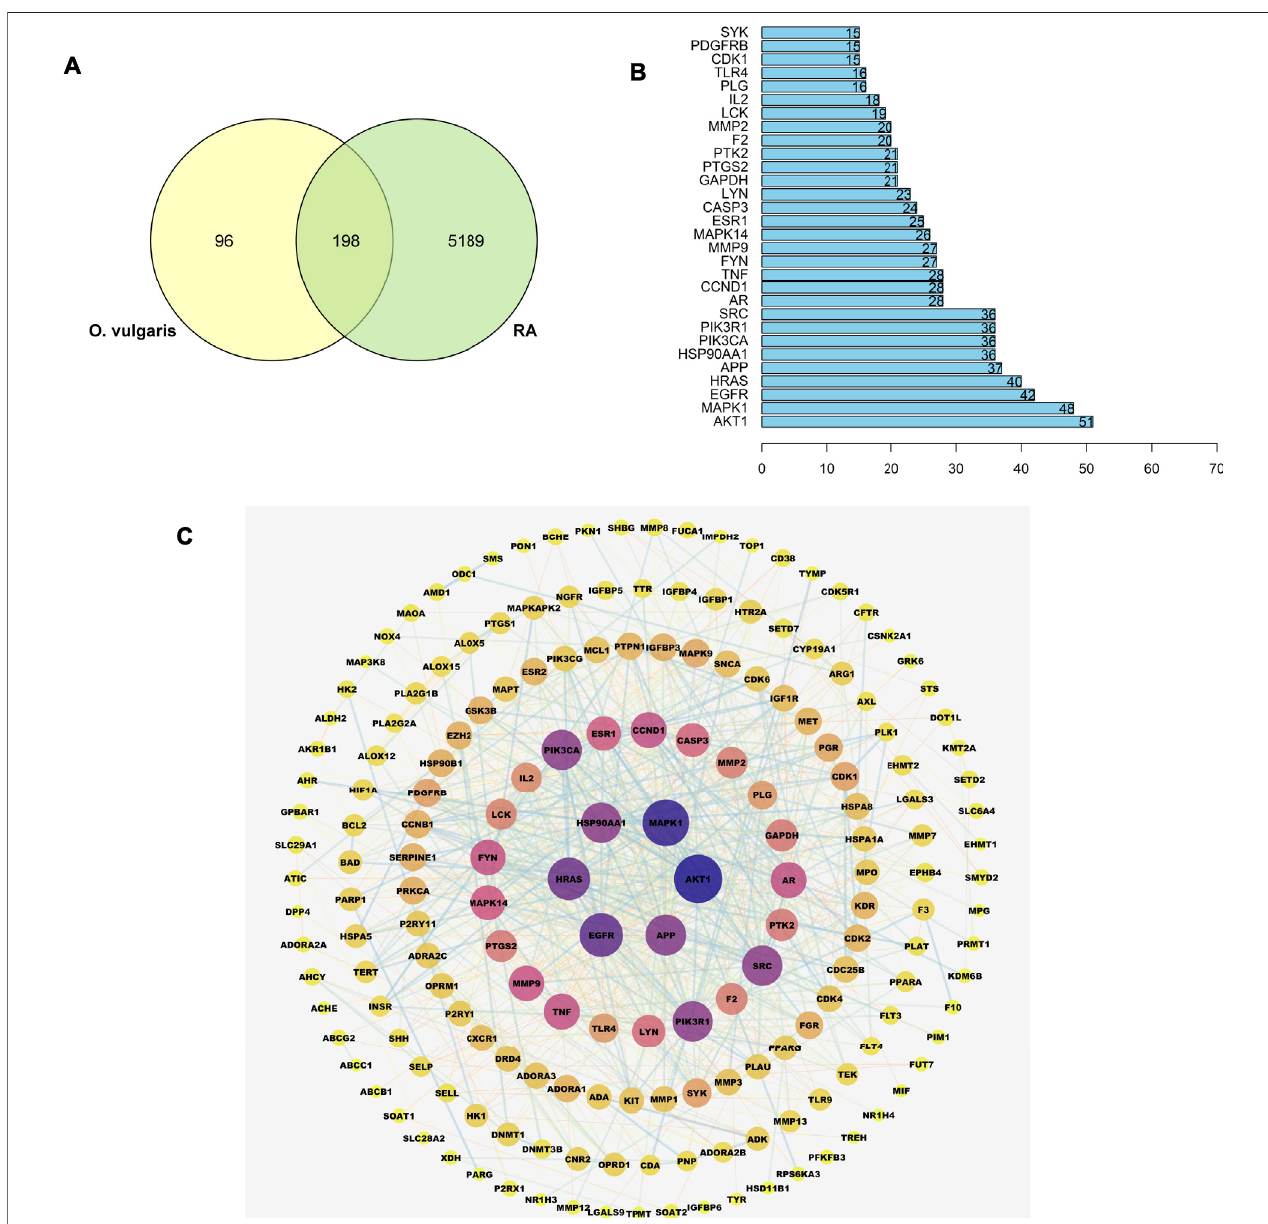
FIGURE 6 | (A) Overlapping genes between RA-related genes and 36 compounds of O. vulgaris related genes; (B) The core gene for O. vulgaris treat RA; (C) PPI network diagram.